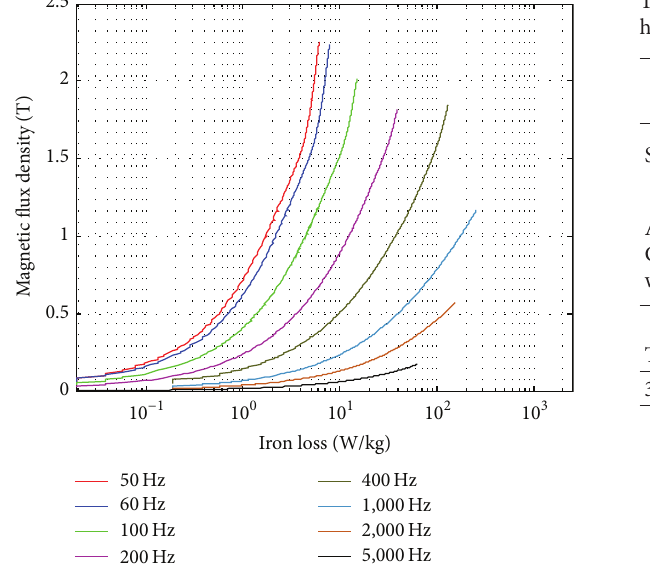
Figure 12: Measurement results obtained from 50 to 5,000 Hz using the new toroidal frame.